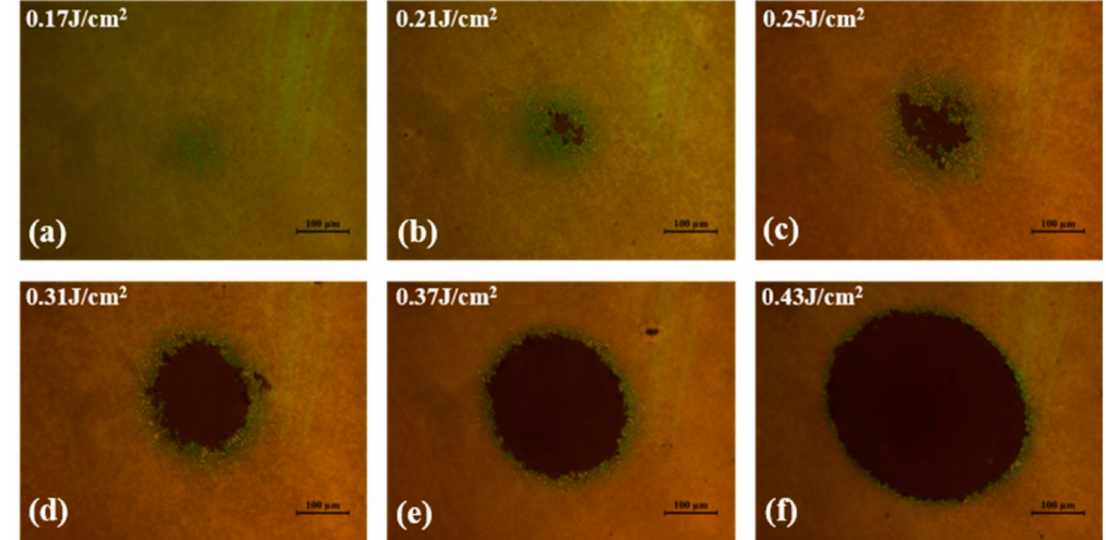
Figure 10. Optical morphologies of the W-doped VO 2 film under different laser fluence